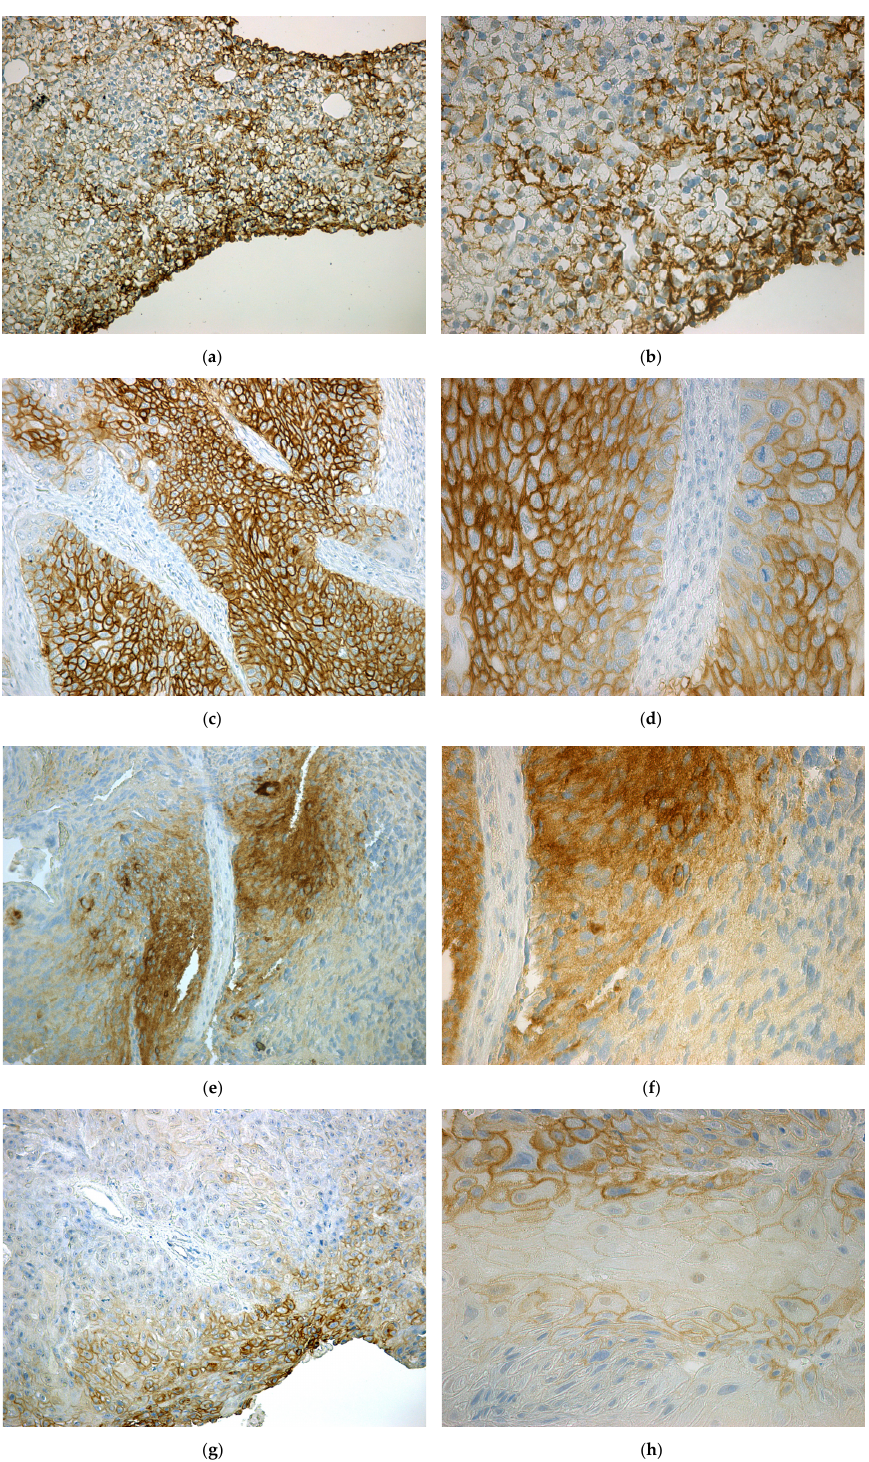
Figure A1. Immunohistochemical staining of human tumor tissues with MAb IV/18. ( a ) Tissue of ccRCC, magnification ∑ 200x; ( b ) tissue of ccRCC, magnification ∑ 400x; ( c ) lung mesothelioma, magnification ∑ 200x; ( d ) lung mesothelioma, magnification ∑ 400x; ( e ) glioblastoma, magnification ∑ 200x; ( f ) glioblastoma, magnification ∑ 400x; ( g ) head and neck carcinoma, magnification ∑ 200x; ( h ) head and neck carcinoma, magnification ∑ 400x.